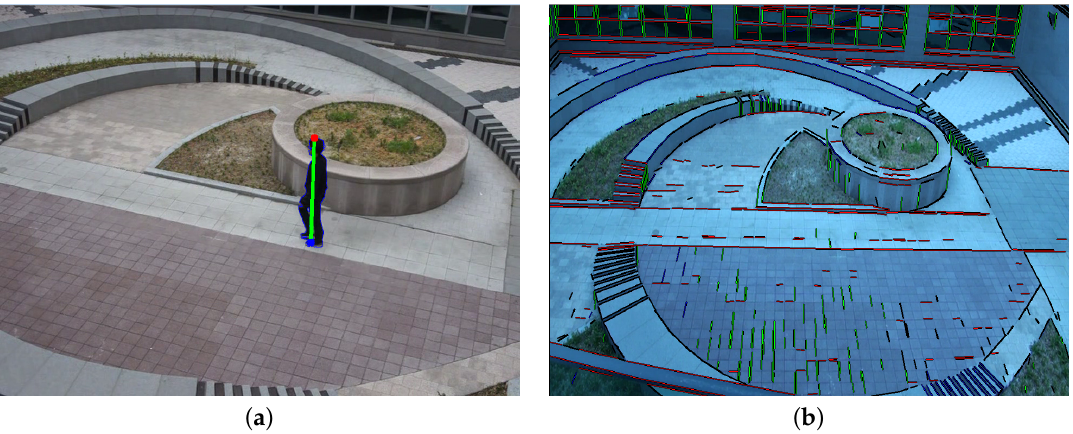
Figure 3. Results of the line detection: ( a ) foot-to-head line and ( b ) background structure